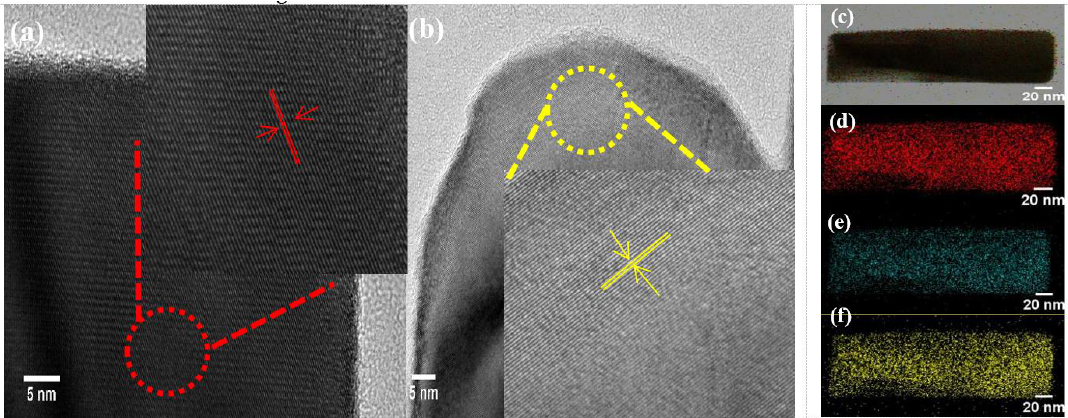
Figure 2. Transmission electron microscopy (TEM) images of as-prepared ( a ) CuBi 2 O 4 and ( b ) CuBi 2 O 4 -OVs, and ( c ) all elements EDS mapping images of CuBi 2 O-OVs, ( d ) Bi 4f, ( e ) Cu 2p, and ( f ) O 1s. The inset image is magnified image of the encircled area.